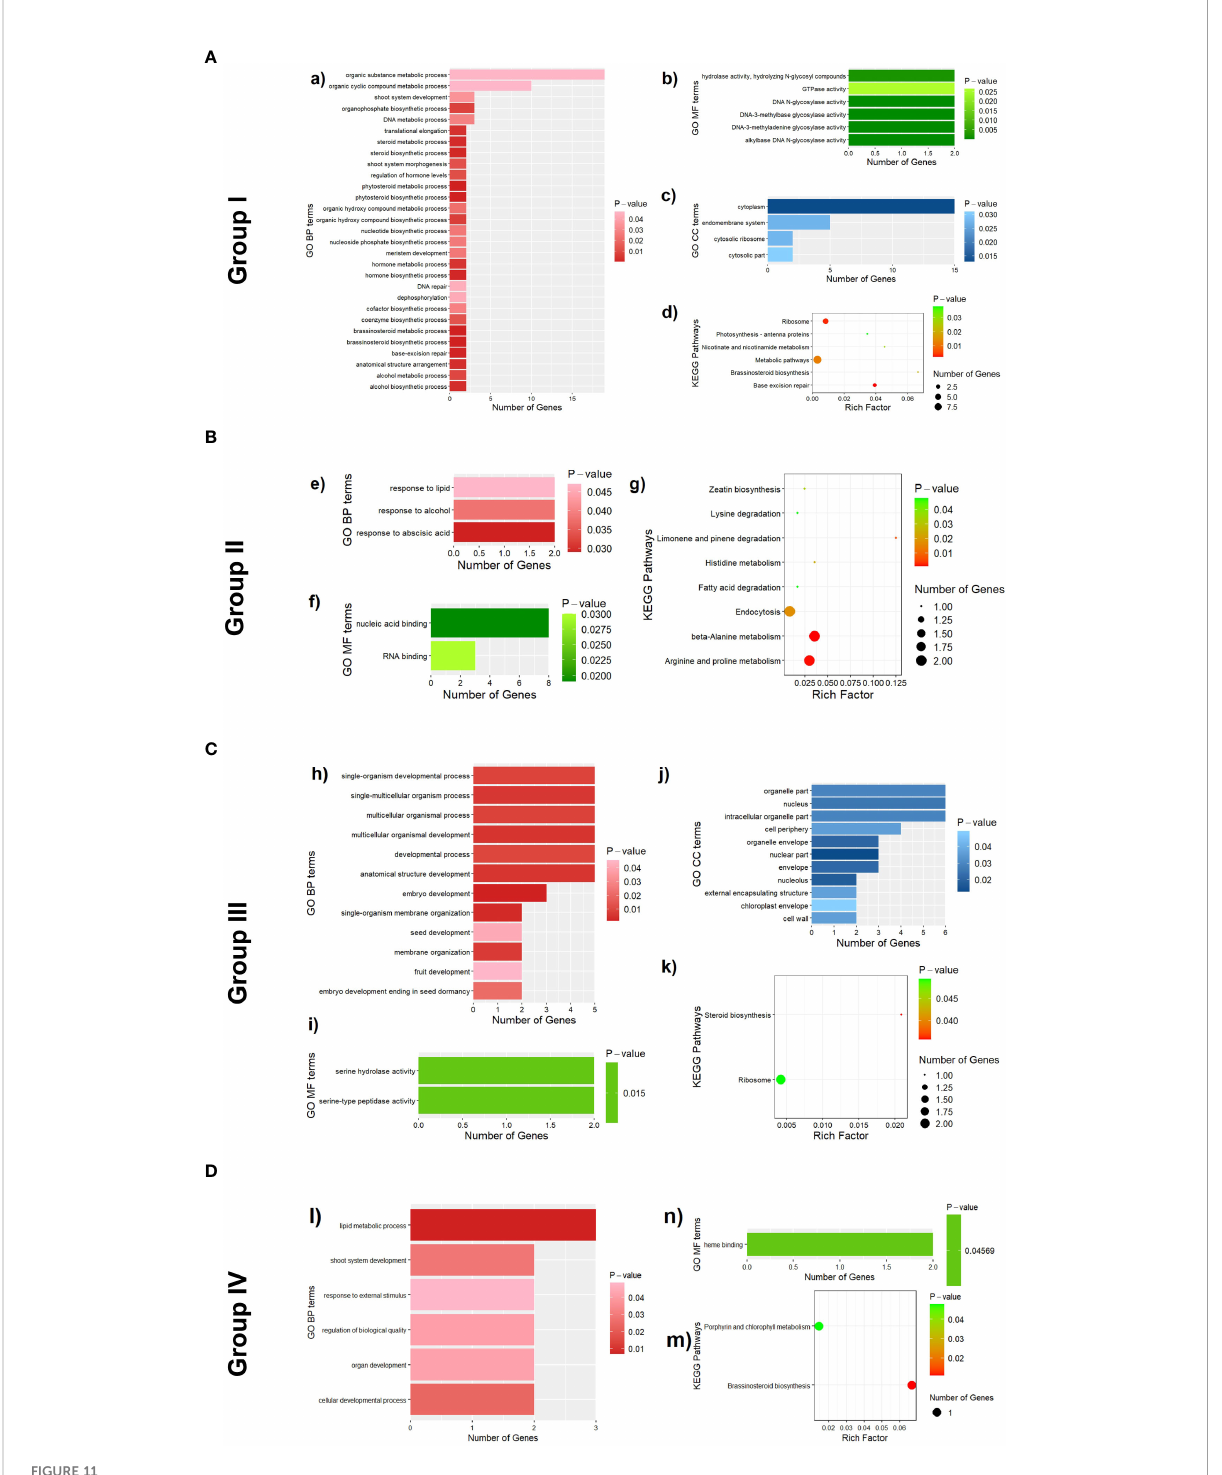
FIGURE 11 Functional enrichment results of 161 candidate genes associated with 13 leaf midrib curve traits. (A) GO terms (a, b and c) and KEGG pathways (d) enriched by candidate genes of traits in Group I. (B) GO terms (e and f) and KEGG pathways (g) enriched by candidate genes of traits in Group II. (C) GO terms (h, I and j) and KEGG pathways (k) enriched by candidate genes of traits in Group III. (D) GO terms (l and n) and KEGG pathways (m) enriched by candidate genes of traits in Group